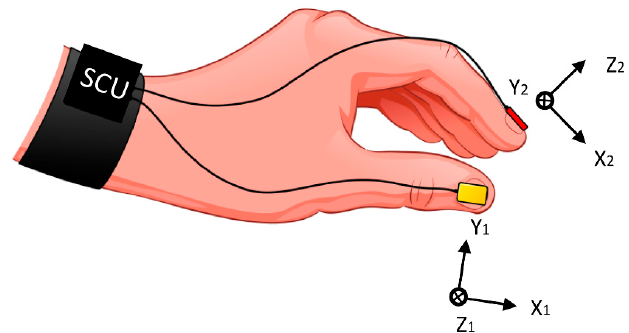
Figure 1. Illustration of the inertial sensor system, with local coordinate systems of the thumb (𝑋 (cid:2869) ,𝑌 (cid:2869) ,𝑍 (cid:2869) ) and index finger (𝑋 (cid:2870) ,𝑌 (cid:2870) ,𝑍 (cid:2870) ) sensors. SCU - sensor-control unit.